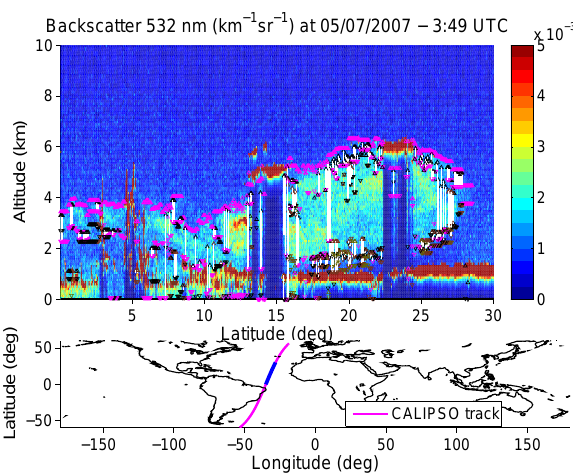
Fig. 1. An example of SAL as observed from CALIOP on 5 July 2007 at 3:49UTC. Top: the latitude-altitude cross section of the attenuated backscatter coefficient at 532µ m ( km − 1 sr − 1 ). The brown features at about 1 km and the elevated ones at about 5 ◦ , 15 ◦ and 22 ◦ N are clouds. The white lines mark the overlap (see text for details) and the triangles (magenta, black or brown) show the top and the base of dust layers as detected by CALIPSO.Bottom: theCALIPSOtrack, withthepartofthecrosssectionpresentedabovehighlightedinblue.